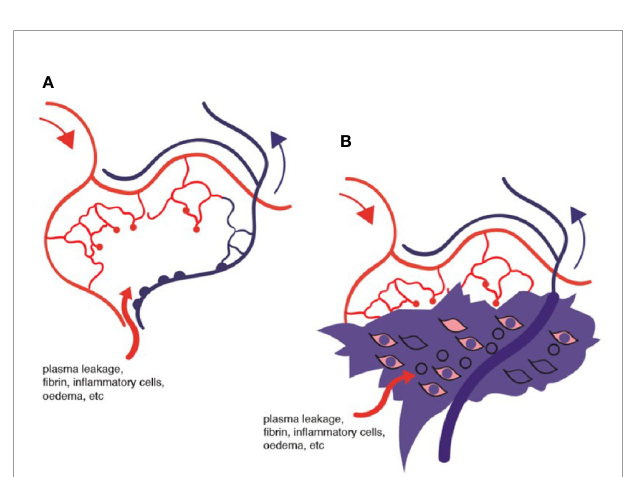
FIGURE 8 | Diagram of ischemic retina: (A) area of ischemia and oedema; (B) representation of tissue fi brin deposition and macrophage in fi ltration surrounding non- fl owing venule.